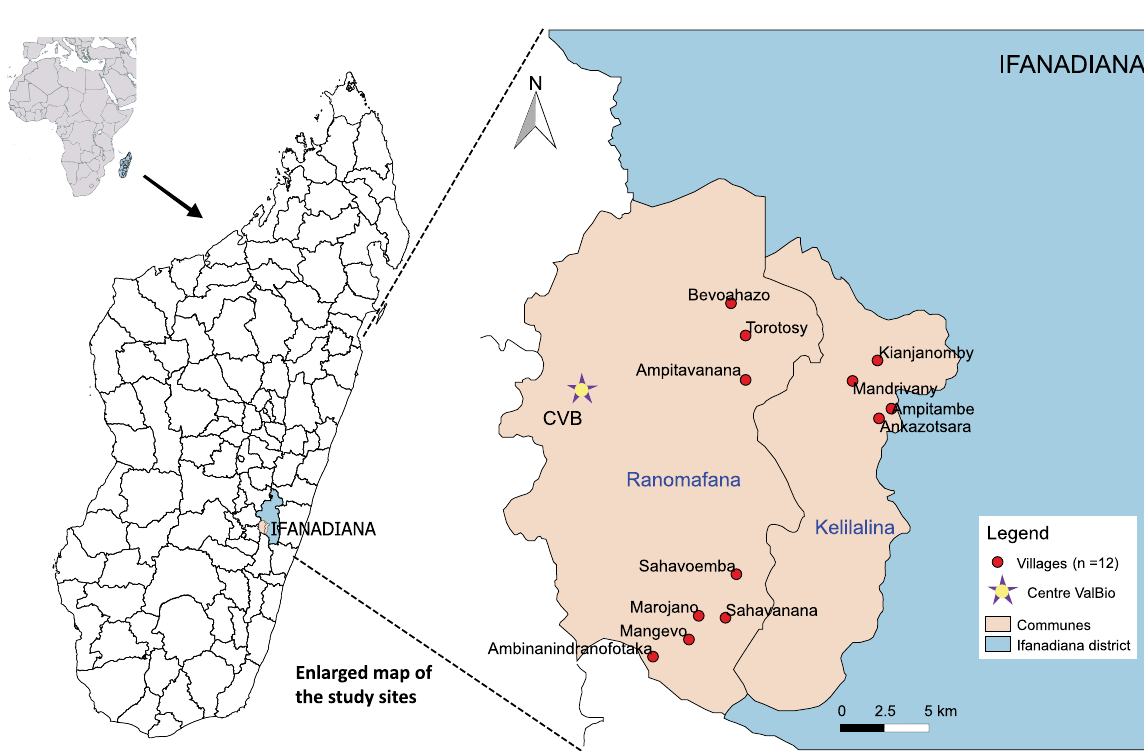
Fig 1. Map of the study sites. Map of Ranomafana and Kelilalina townships (Ifanadiana District) showing the twelve villages where sampling was carried out. The figure was created using the humanitarian Data Exchange (HDX) accessible from OCHA (United Nations Office for the Coordination of Humanitarian Affairs) services and using QGIS 2.8.1. https://data.humdata.org/dataset/madagascar-administrative-level-0- 4-boundaries. Details on the corresponding license can be accessed via the link below: https://data.humdata.org/about/license.